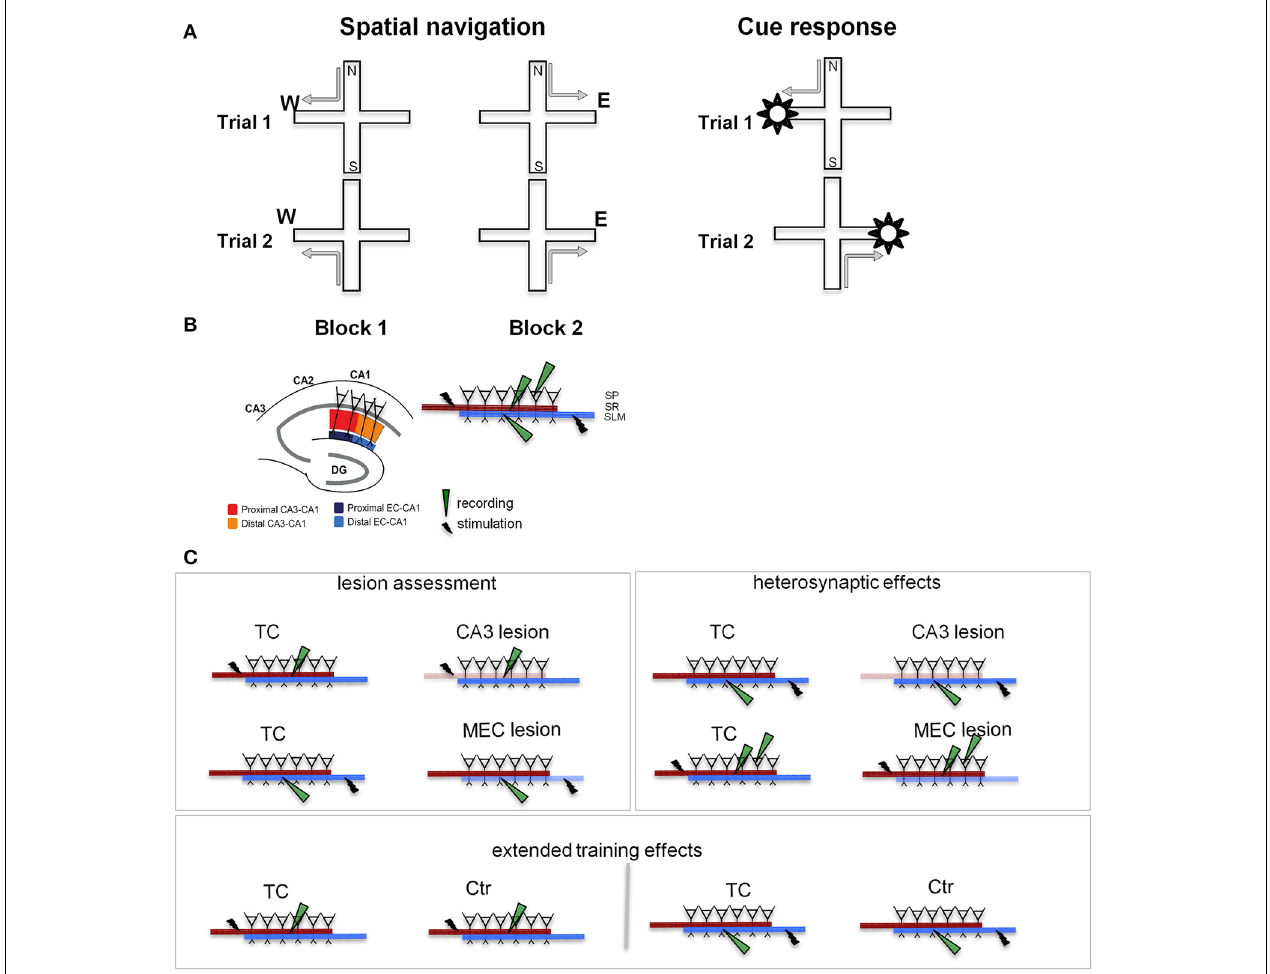
FIGURE 1 | Behavioral training and testing were followed by slice recording. (A) Experimental design. We TC animals in two different tasks on the plus maze: a spatial navigation task (left) and a cue-response task (right). In bothcases,theratswalkedfromoneofapairofoppositestartarmstothegoal arm that was baited on the particular trial. In the spatial memory task the animals had to remember the location of the food, while in the cue response tasktheyhadtorememberacue-motorresponseassociation.Thus,therathad to choose and consistently use the appropriate strategy. Neither task involved spatial or body turn alternation (see Supplementary Figure 1), but required either spatial navigation, or a cue-response strategy. (B) Stimulation and recording in hippocampal slices. The segregation of inputs to CA1 field permits evaluation of CA3 and MEC lesions on the neurophysiology of the local CA1 circuit. Separate sets of recordings were performed for the proximal (close to CA3) and distal (close to subiculum) areas of the CA1. The inset details the placement of stimulation/recording electrodes in stratum radiatum (SR), stratum lacunosum-moleculare (SLM), and stratum pyramidale (SP), where the somas of CA1 neurons are located. Synaptic transmission in the CA3-CA1 pathway was assessed by stimulating and recording fEPSPs in the stratum